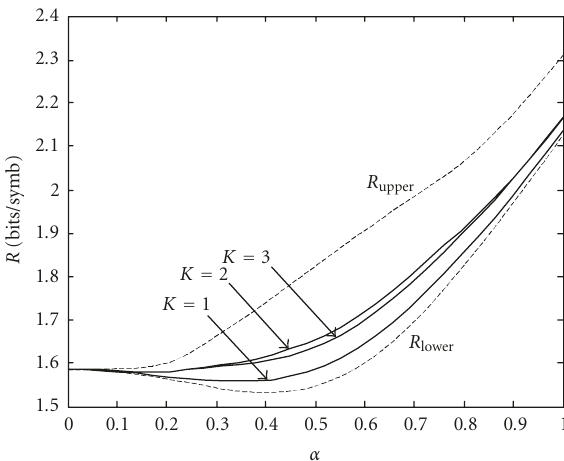
intracell TDMA versus the intercell gain α. The lower bound (4) and upper bound (6) are also shown for reference ( (cid:4) P = 3dB, C = 1, J = 1) .